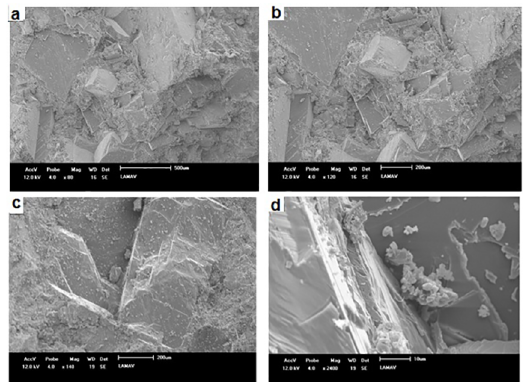
Figure 3. (a, b, c, d) Scanning electron micrographs of fracture surfaces of the artificial marble produced increases with 80x (a), 120x (b), 140x (c) and 2400x (d).